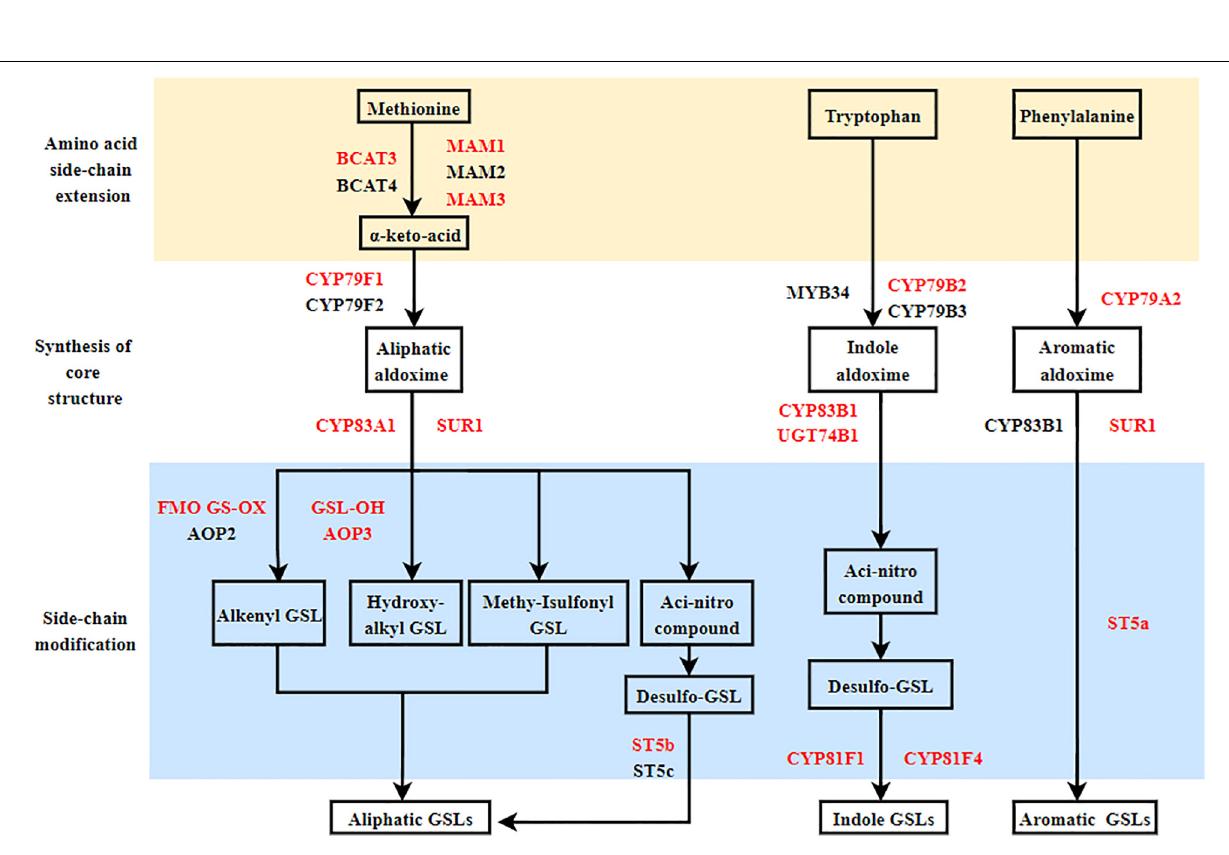
Frontiers in Plant Science |